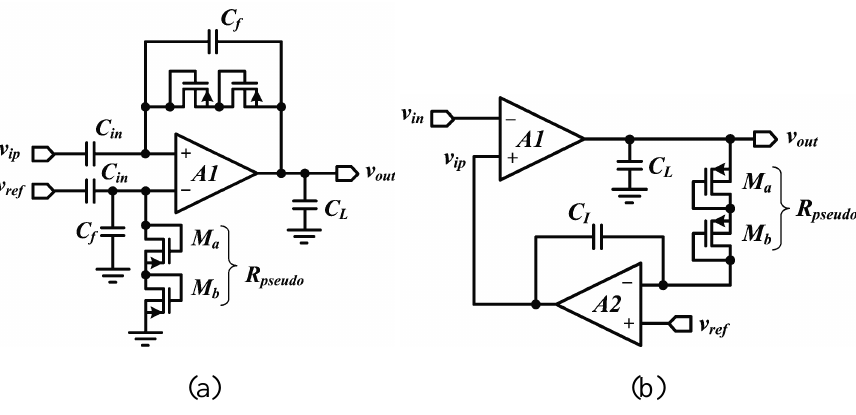
Figure 2. (a) Schematic of a capacitive-feedback neural amplifier. (b) Schematic of an active-feedback neural